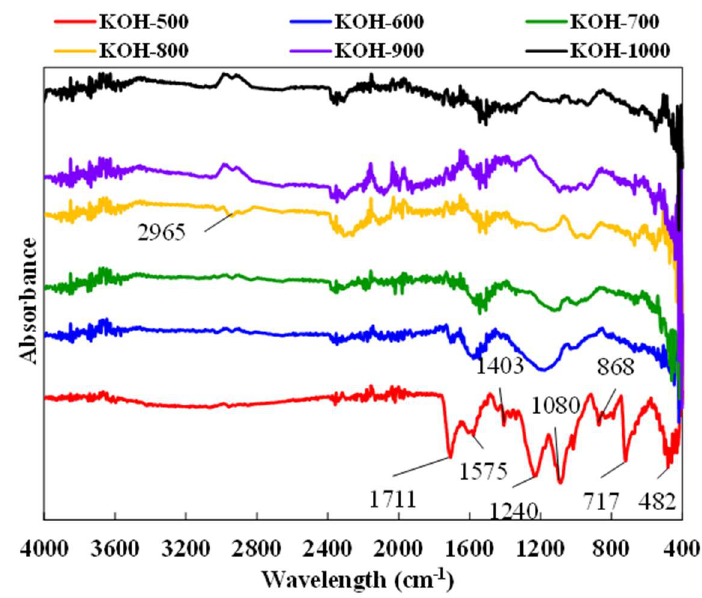
Figure 6. FTIR spectra of KOH ACs prepared at different activation temperatures.